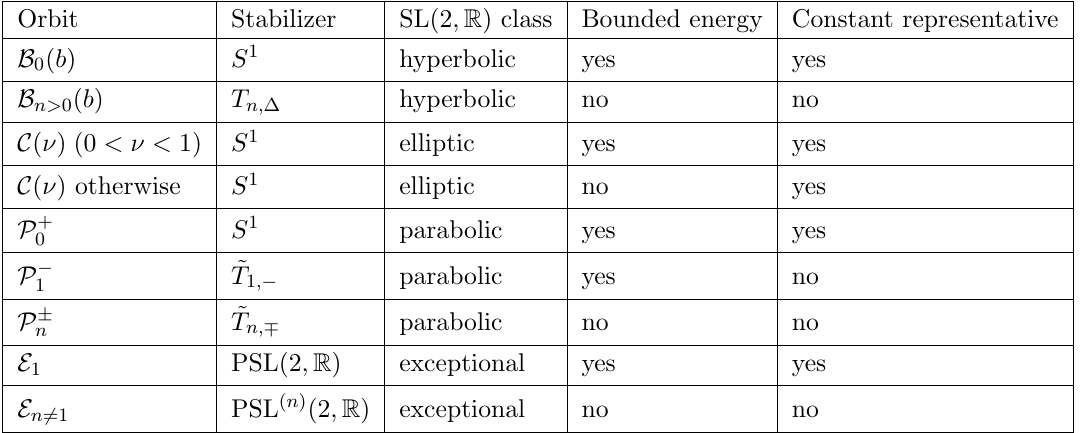
Table 4 . Relevant features of the Virasoro coadjoint orbits as classi(cid:12)ed in